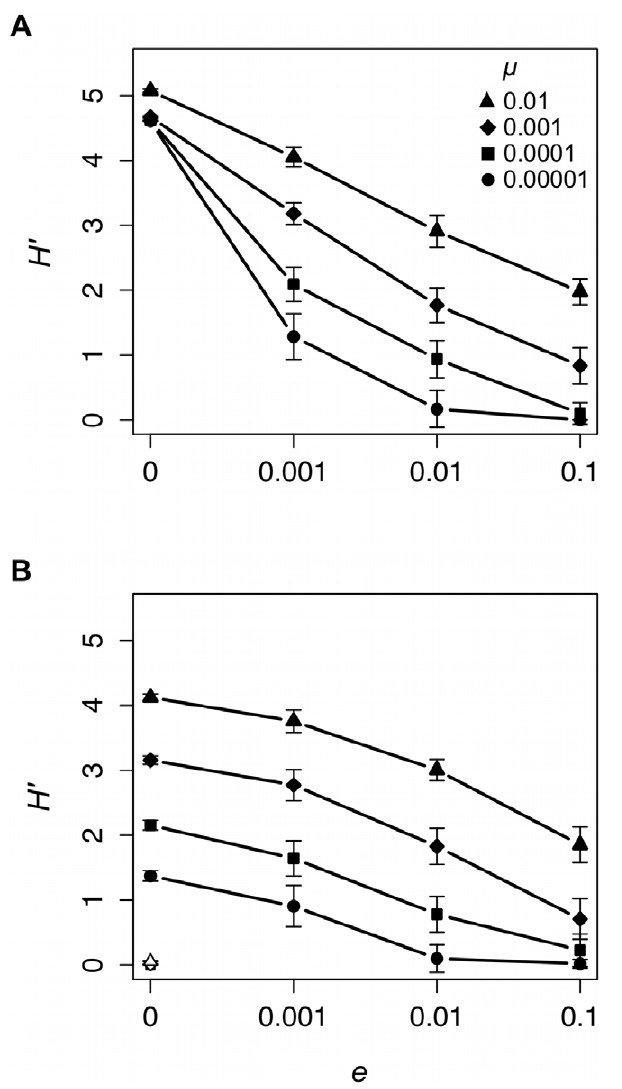
Figure 3. Local extinction rate ( e ) affects total cultural diversity as measured by Shannon’s H 9 under equilibrium (A) and non- equilibrium (B) conditions. Each data point provides the mean 6 1 standard deviation of 20 unique simulated populations. Black symbols represent data collected from populations with unbiased cultural transmission and white symbols data collected from populations with conformist cultural transmission. doi:10.1371/journal.pone.0015582.g003 equilibrium ( m =0.00001: x 2 = 71.68, P , 0.001; m = 0.0001: x 2 = 73.80, P , 0.001; m =0.001: x 2 = 73.35, P , 0.001; m = 0.01: x 2 = 74.07, P , 0.001) and non-equilibrium ( m = 0.00001: x 2 = 64.62, P , 0.001; m = 0.0001: x 2 = 69.84, P , 0.001; m =0.001: